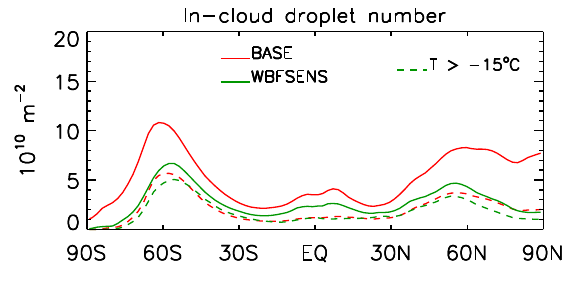
Fig. 14. As Fig. 3a for the BASE and the WBFSENS sensitivity